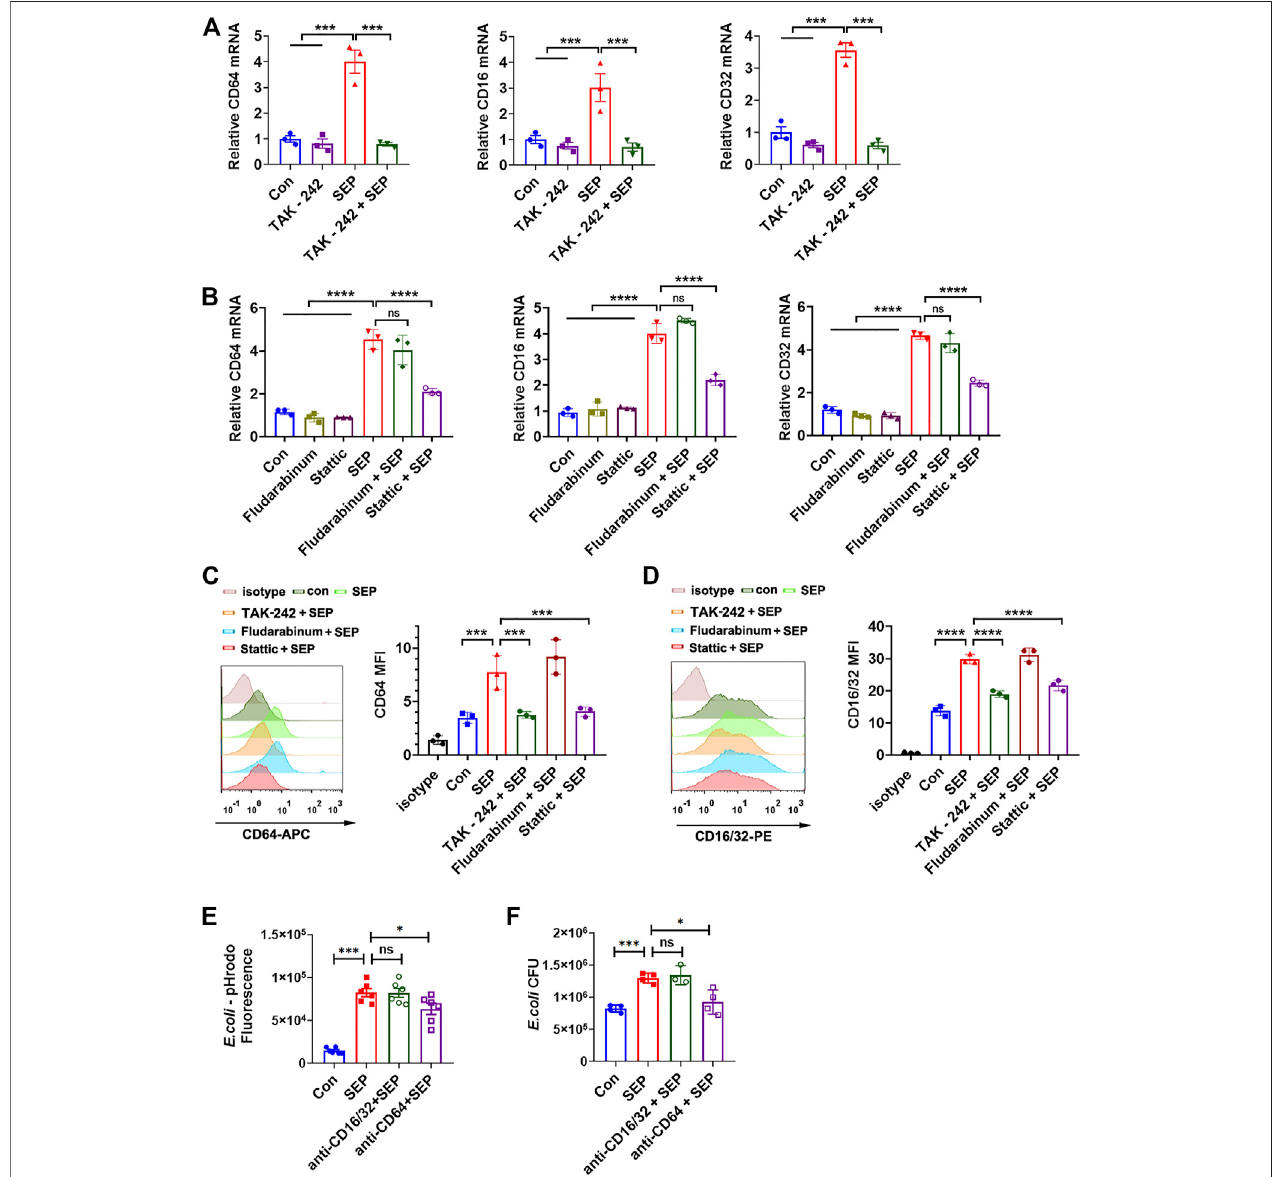
FIGURE4| CD64isresponsibleforSEPinducedphagocytosis via TLR4/STAT3signals. (A,B) TheeffectsofSEPontherelativemRNAexpressionofCD64,CD32 and CD16 were determined by q-PCR. (C,D) The effects of SEP on the protein levels of CD64 and CD16/32 were determined by fl ow cytometry. (E) RAW264.7 cells were pre-treated with SEP (100 μ g/ml) for 24 h, and followed by incubation with 2 μ g/ml anti-CD64 or anti-CD16/32 blocking antibodies for 1 h prior to pHrodo- E. coli infection. Then macrophage phagocytosis was quanti fi ed by the fl uorescence. (F) The effects of blocking CD64 or anti-CD16/32 on phagocytosis of live E. coli by macrophages were measured by gentamicin protection assay. All data are represented as mean ± SEM acquired in triplicate determinations. * p < 0.05, *** p < 0.001,**** p < 0.0001. ns, not signi fi cant.